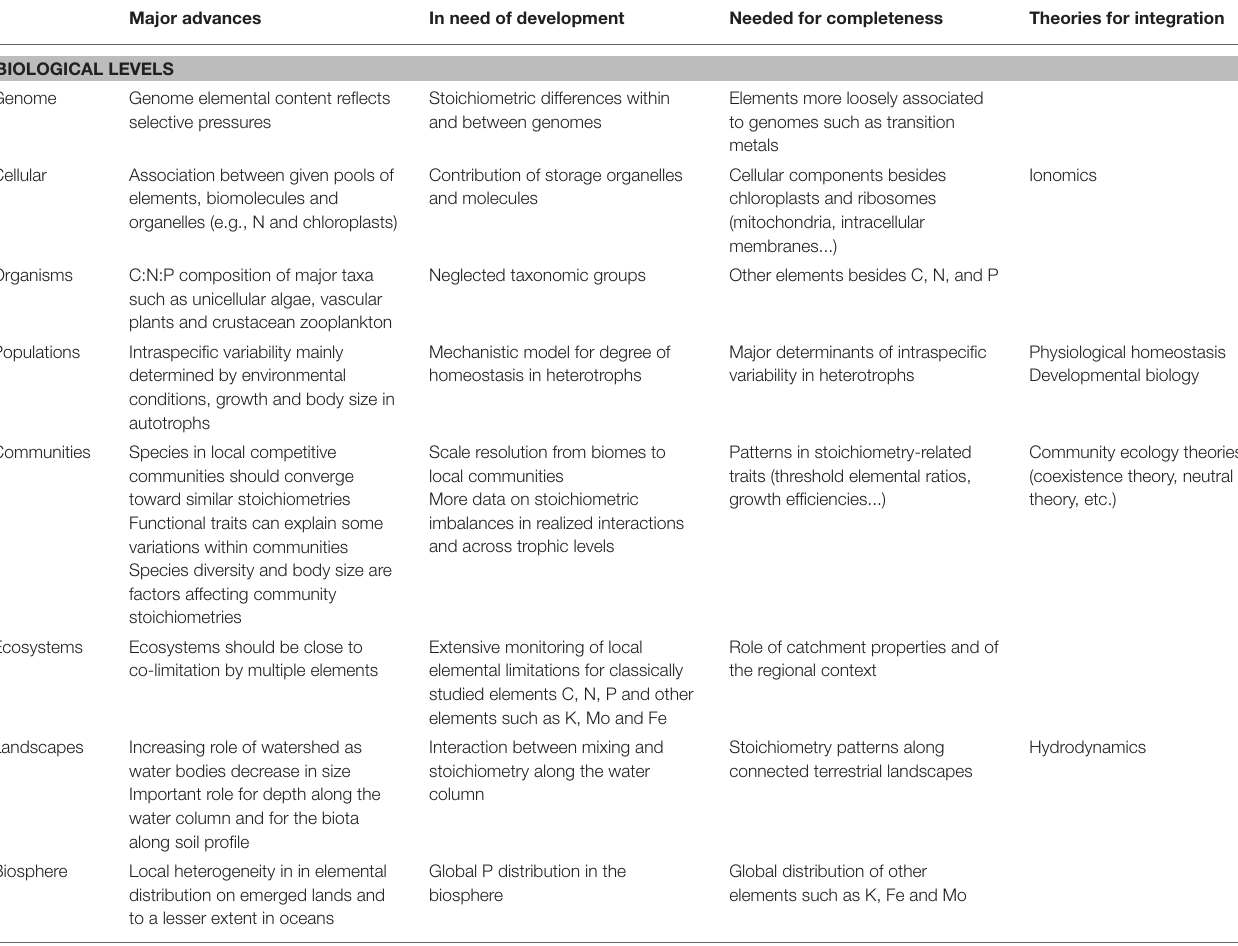
TABLE 1 | Brief summary of the major advances at each biological level of our framework for a molecule-to biosphere stoichiometry theory and of the elements of understanding identified as in need of improvement. Major